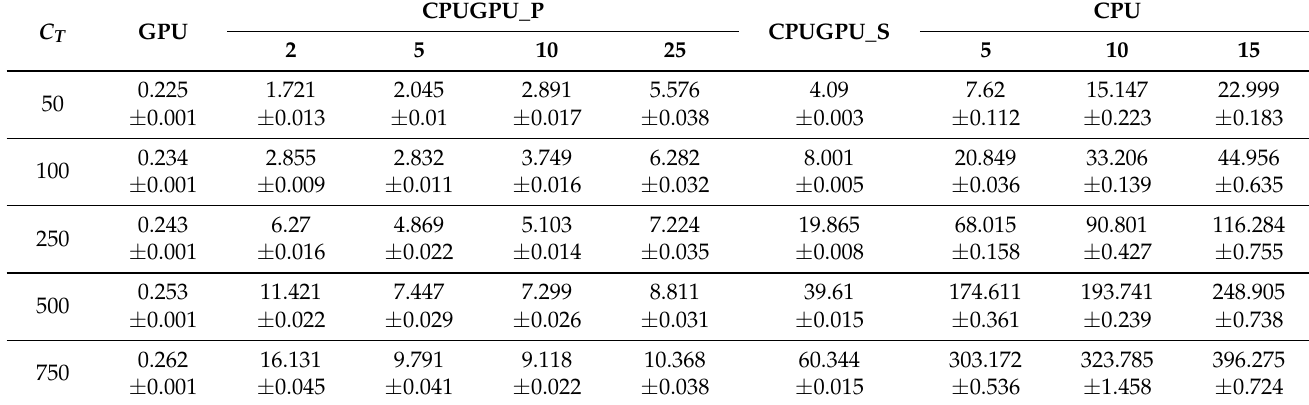
Table 1. Effect of number of observations on computation time. Results of experiments for random action without DNN model ( C S = 50).